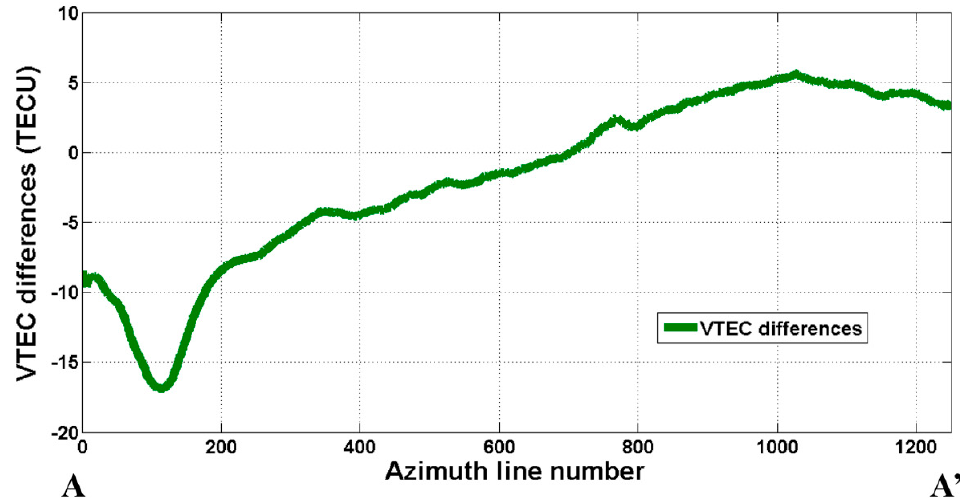
Figure 5. VTEC difference map in profile A-A’ of Figure 4d. Figure 5. VTEC di ff erence map in profile A-A’ of Figure